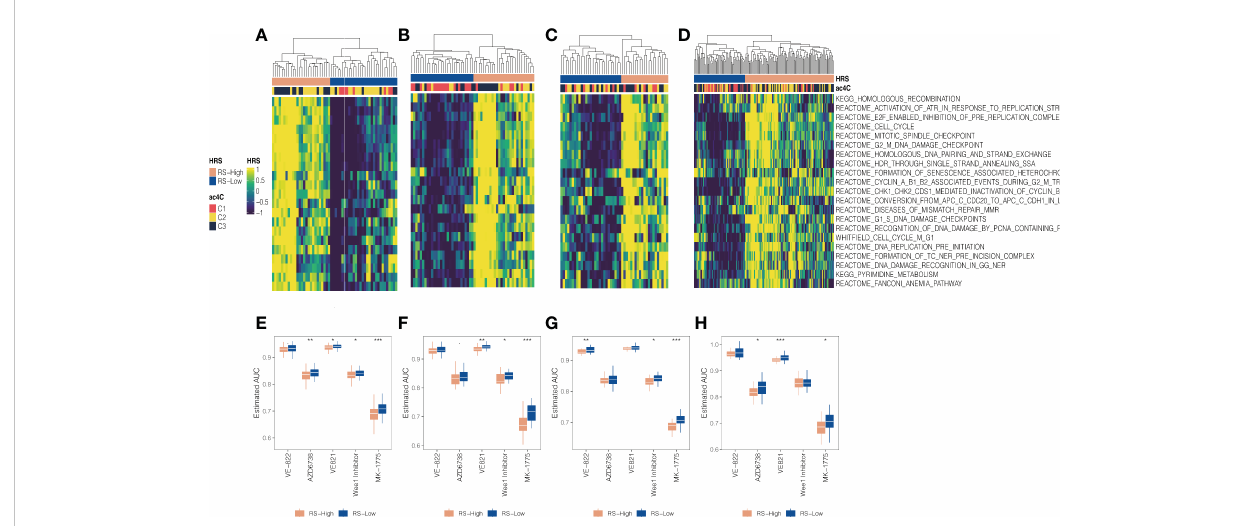
FIGURE 6 Association between DNA replication stress and NAT10-relevant subtypes in PDAC. Replication stress and DNA damage response activate pathways and molecular processes involved in DNA maintenance and cell cycle regulation. Two replication stress (RS) subtypes were identi fi ed for the (A) TCGA cohort, (B) GEO cohort, (C) PACA_AU cohort, and (D) E-MTAB-6134 cohort, respectively. (D) Boxplot showing distribution of estimated AUC concerning ATR and WEE1 inhibitors between two RS subtypes for the (E) TCGA cohort, (F) GEO cohort, (G) PACA_AU cohort, and (H) E-MTAB-6134 cohort, respectively. * means P < 0.05, ** means P < 0.01, *** means P <